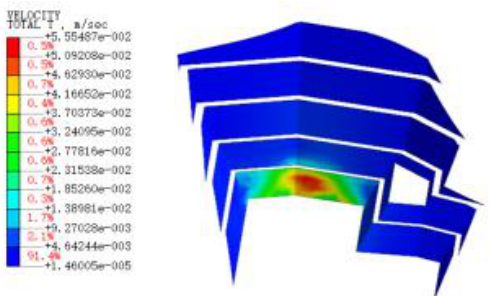
Figure 15. The vibration velocities of retaining walls at 50 ms.